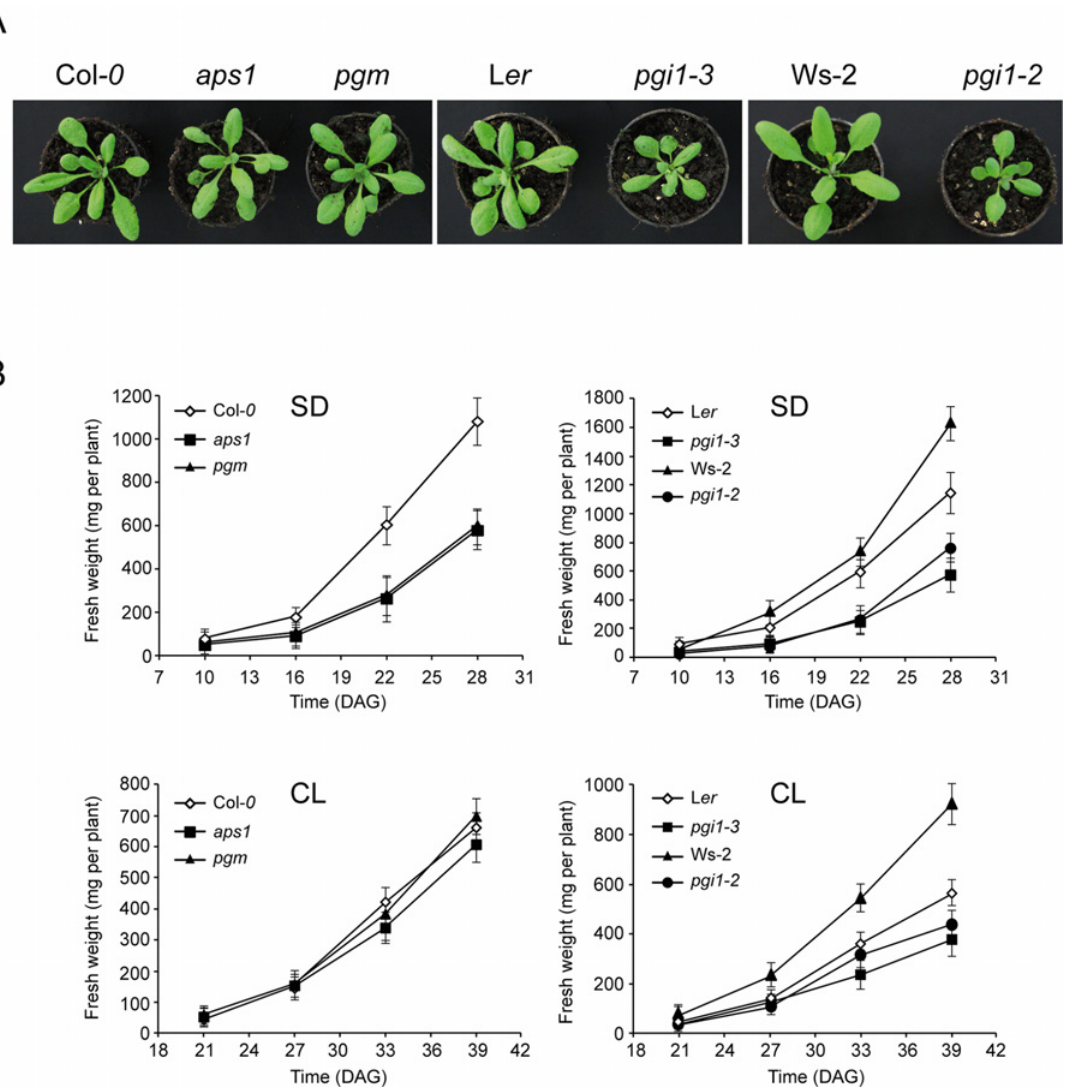
Fig 9. pgi1 – 2 and pgi1 – 3 leaves display a slow growth phenotype under SD and CL photoperiod conditions. (A) Photographs of 25 DAG WT, aps1 , pgm , pgi1 – 2 and pgi1 – 3 plants cultivated in growth cabinets under CL conditions. (B) Time-course of FW of rosettes of WT, aps1 , pgm , pgi1 – 2 and pgi1 – 3 plants cultured on soil under SD and CL conditions. In “ B ” , values represent the mean ± SE of determinations on four independent